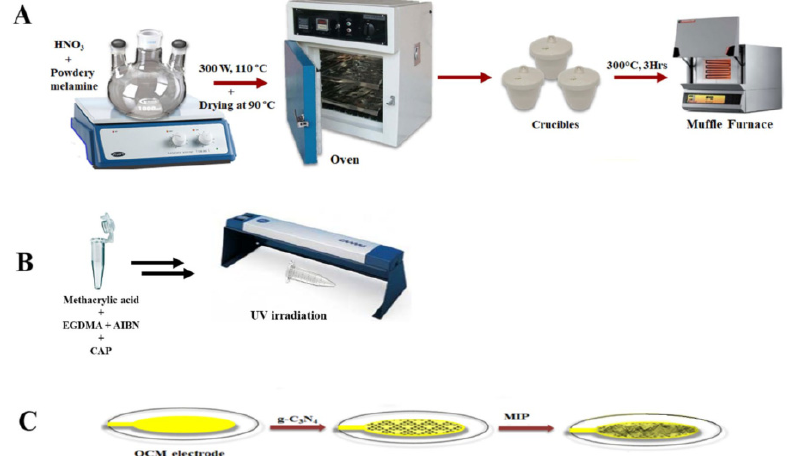
Figure 12. Schematic diagram illustrating the ( A ) synthesis of g-C 3 N 4 nanosheets, ( B ) synthesis of MIP ( C ) and design of the mass-sensitive nanointerfaces for the detection of chloramphenicol [76].